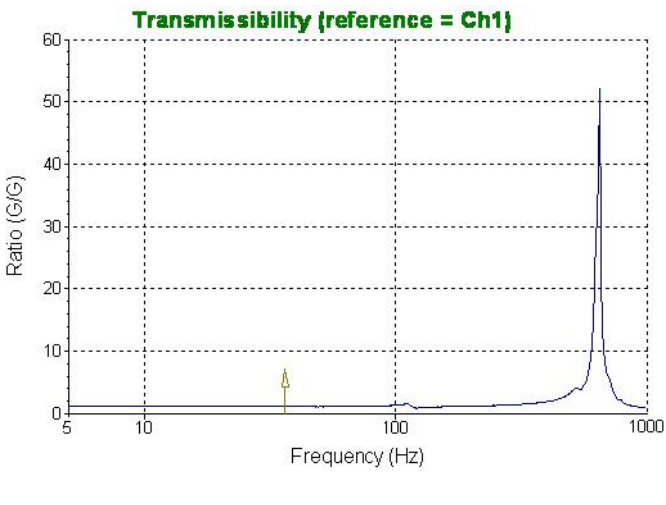
Figure 3. Frequency response of the